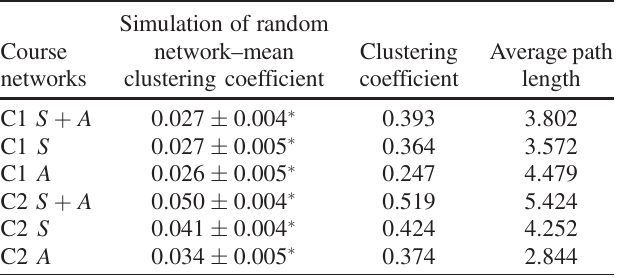
TABLE I. Clustering coefficient and average path length for all networks of each course. C1 is Course One, C2 is Course Two, S þ A denotes the combined network, S denotes the social network, A denotes the academic network, and the asterisk denotes standard error of 1000 random simulated